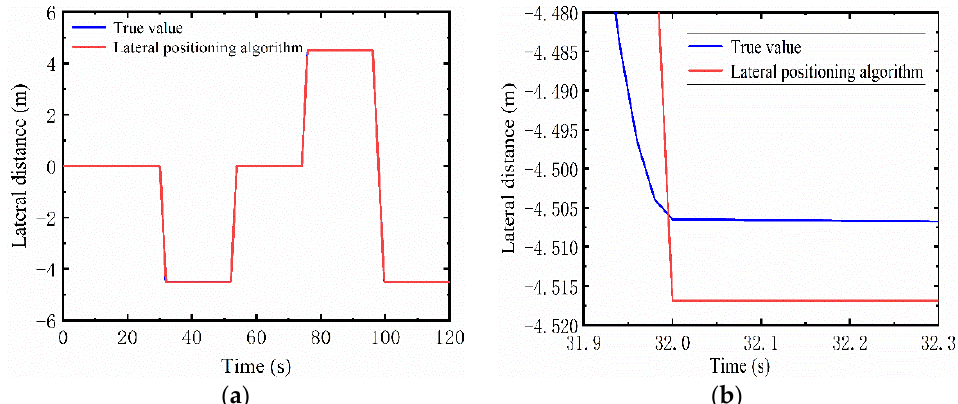
Figure 12. Lateral distance variation based on the algorithm of this paper: ( a ) Lateral distance vari-